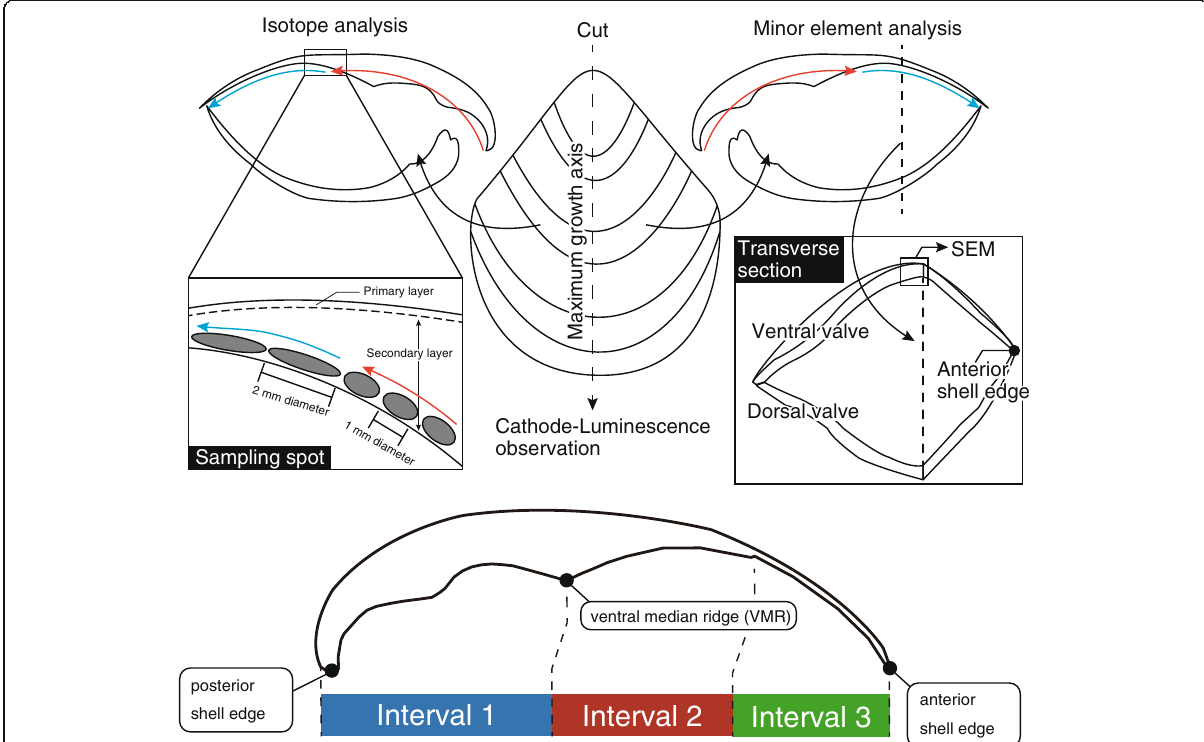
Fig. 3 Schematic illustration of the sampling procedure for geochemical analyses of the modern and fossil shells. The red and blue arrows indicate sampling intervals of 1 and 2 mm, respectively. Shells were cut along the maximum growth line and then along a line perpendicular to the maximum growth axis. Thin sections along the maximum growth axis were examined in CL images. SEM observations were carried out on the cross-section along the line perpendicular to the maximum growth axis. Individual shells were divided into three intervals (intervals 1 – 3) based on the shell